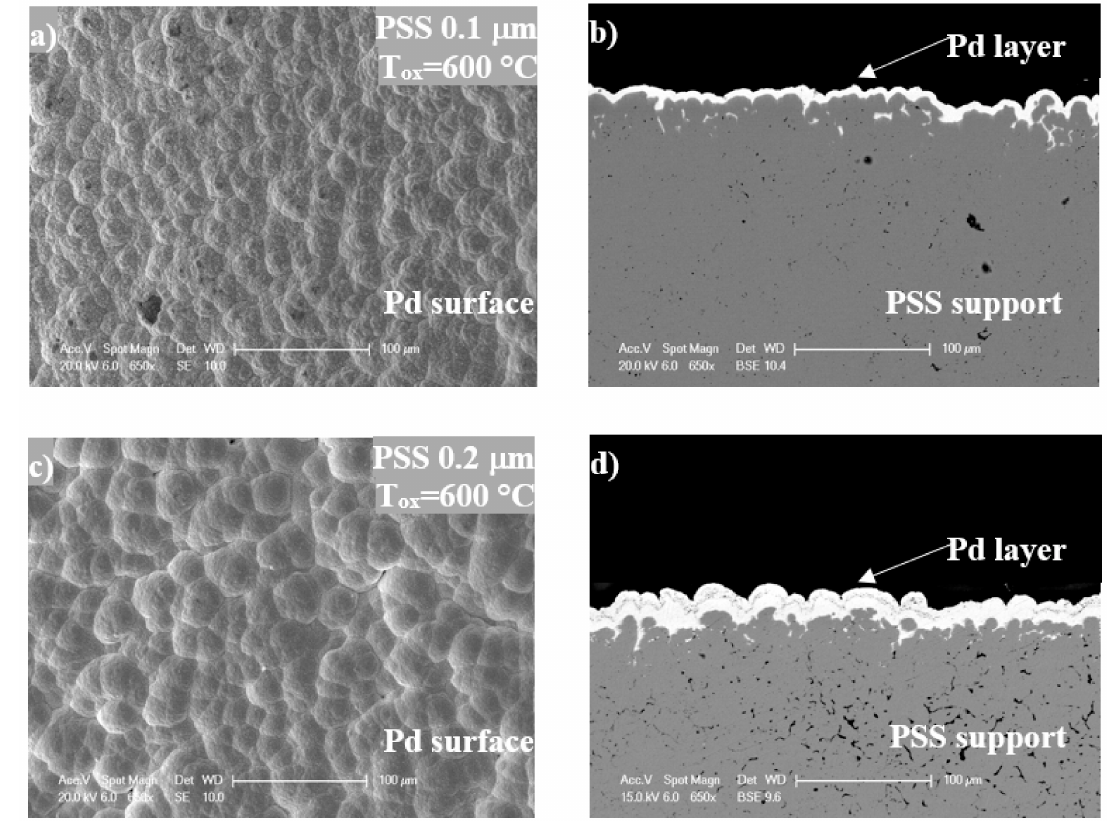
Figure 5. SEM images of modified supports (in-situ oxidation at 600 ◦ C for 12 h) after Pd incorporation by ELP-PP: ( a ) media grade 0.1 µ m, external surface; ( b ) media grade 0.1 µ m, cross-section; ( c ) media grade 0.2 µ m, external surface; and ( d ) media grade 0.2 µ m,